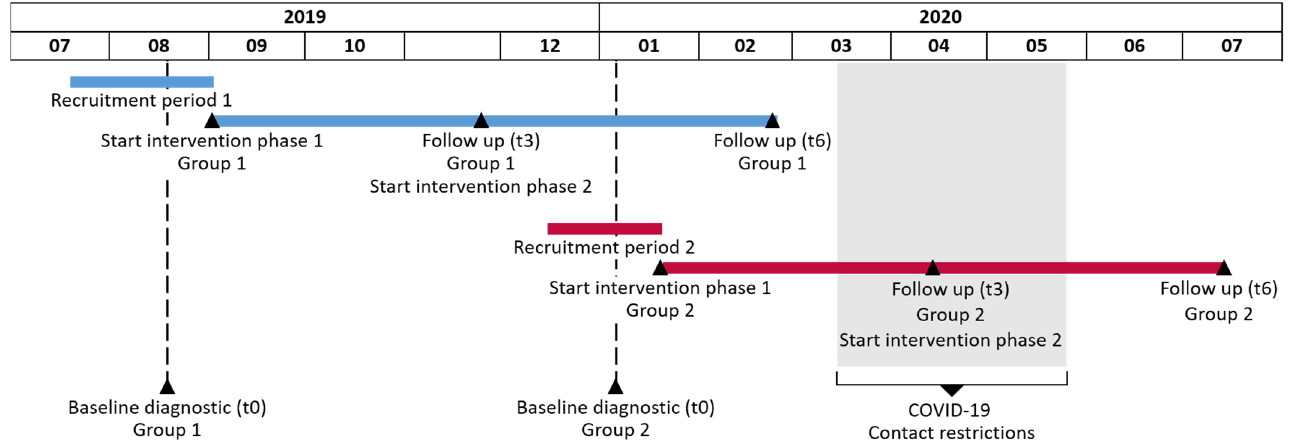
Figure 1. Study timeline. Blue lines represent relevant time points of the first recruitment group, red lines of the second recruitment group. The grey box shows the time of the COVID-19 contact restrictions in Germany. During this time no on-site appointments were possible.